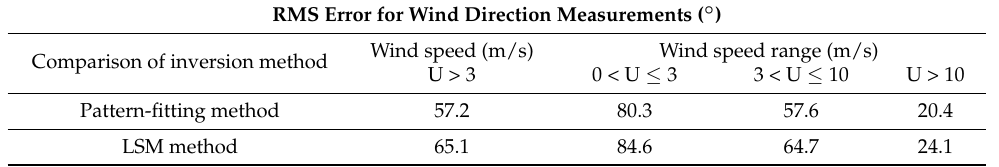
pattern-fitting and LSM methods in the Ligurian Sea experiment.